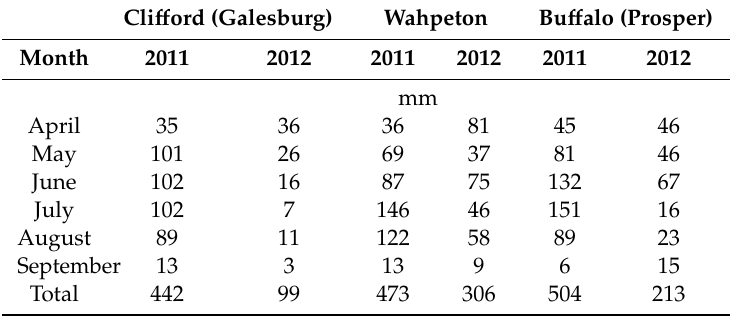
Table 3. Monthly rainfall totals from 2011 and 2012 measured for Cli ff ord, Wahpeton, and Bu ff alo locations, collected from the nearest NDAWN weather station (in parenthesis).